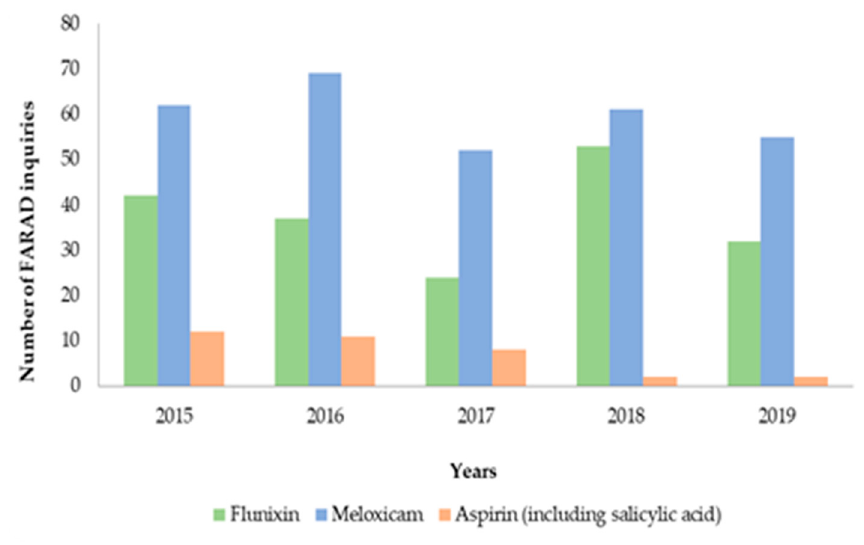
Figure 1. Food Animal Residue Avoidance Databank (FARAD) cattle inquiry number for flunixin ( n = 187), meloxicam ( n = 299), and aspirin ( n = 34) for year 2015 to 2019.